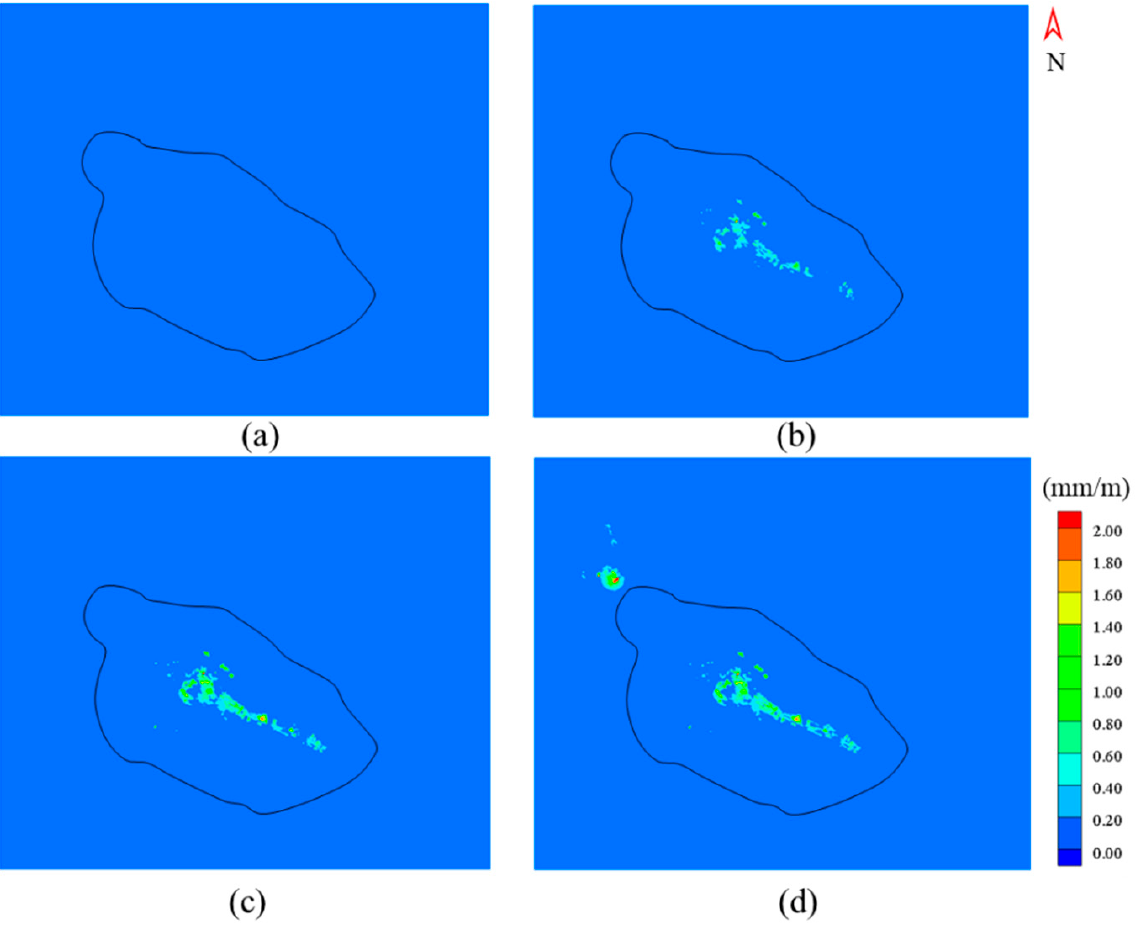
Figure 19. Surface vertical strain ( a ) moment 1; ( b ) moment 2; ( c ) moment 3; ( d ) moment 4.